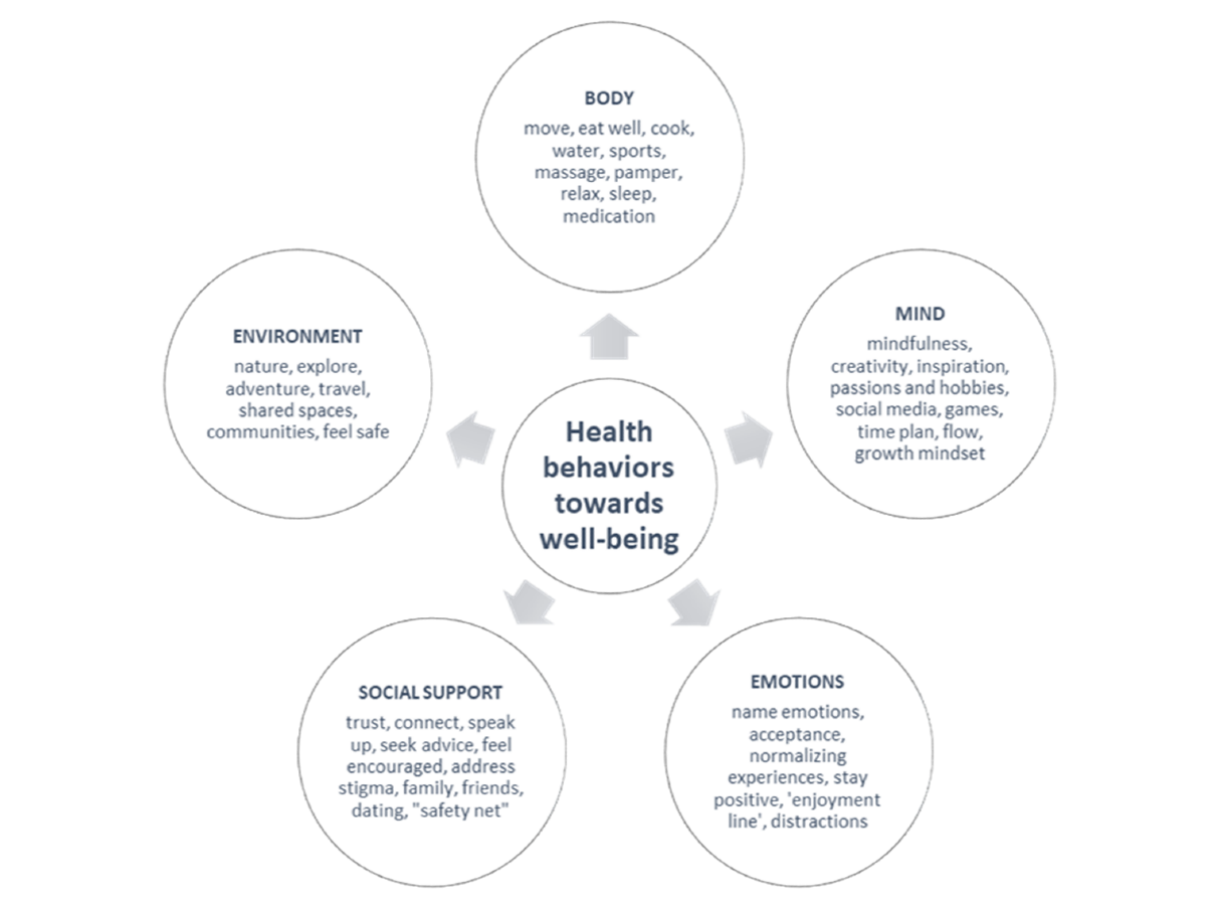
Figure 6. Health-enhancing behaviors for